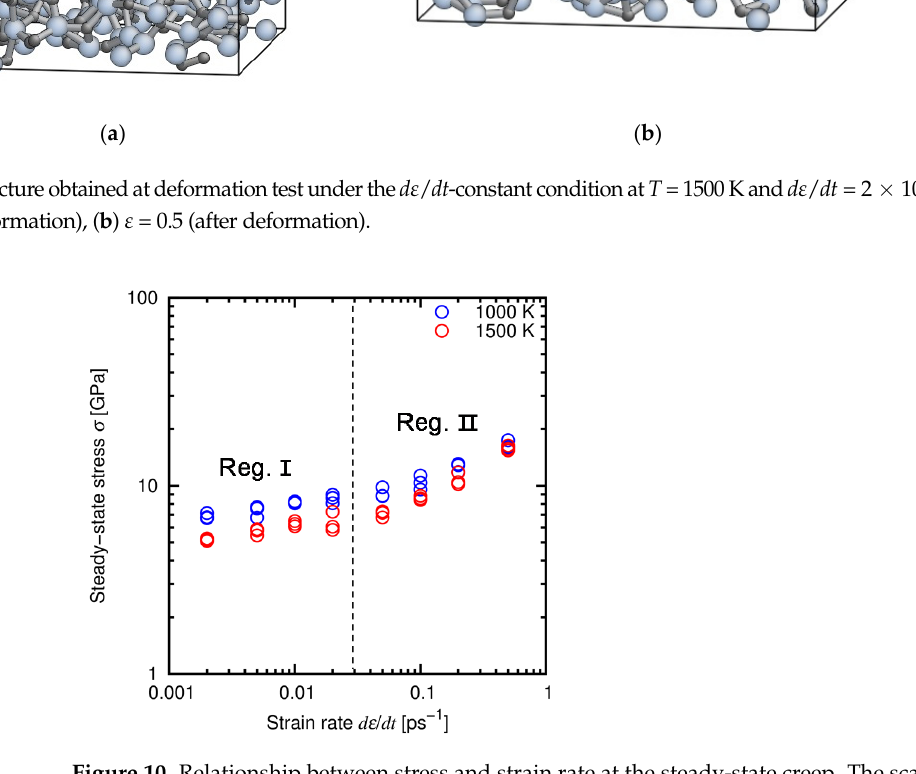
Figure 10. Relationship between stress and strain rate at the steady-state creep. The scales are shown in a logarithmic form. The vertical dashed line indicates the border of Regions I and II.